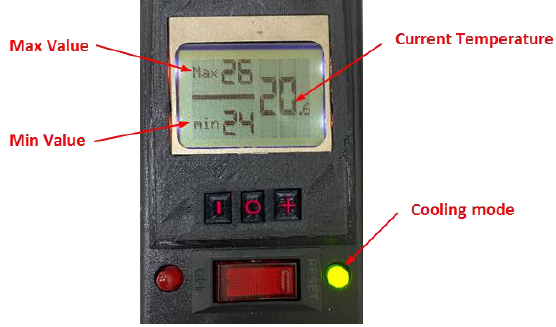
Figure 6. Cooling mode example. It is currently set to cooling mode. The high temperature value is 26 °C, the low temperature value is 24 °C and the current temperature is 20.6 °C.